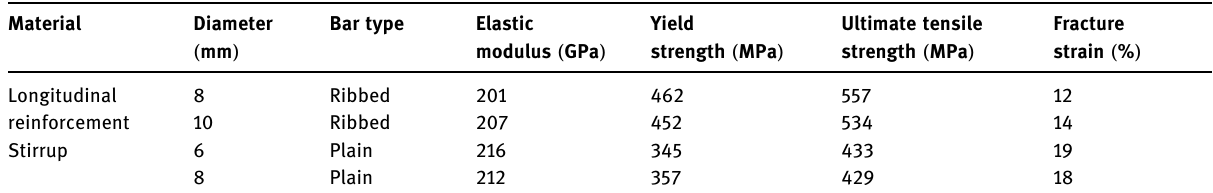
Table 4: Properties of the steel bars ( average values )